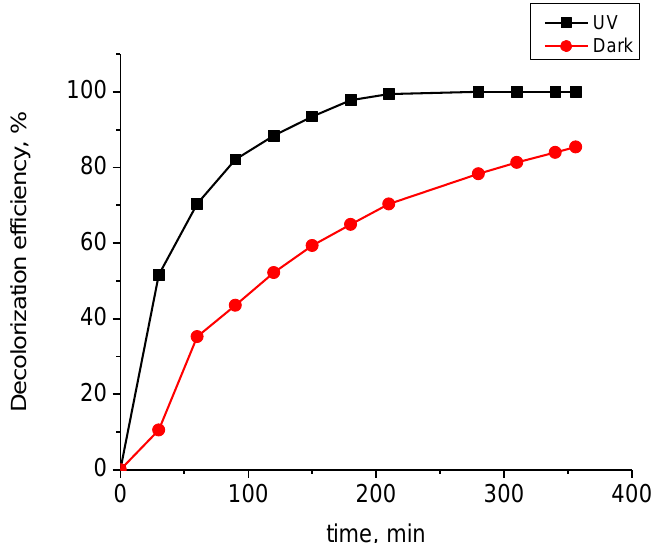
Figure 7. Discoloration in the dark and upon UV illumination of a dye solution at a concentration 50 mg L −1 and PA30 composite material (13.3 g L −1 ).